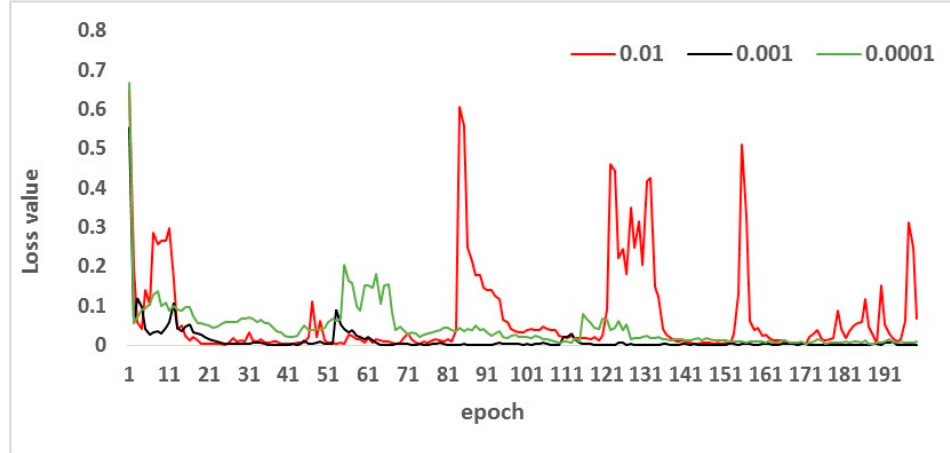
Figure 6. Impact of experience pool on loss value.